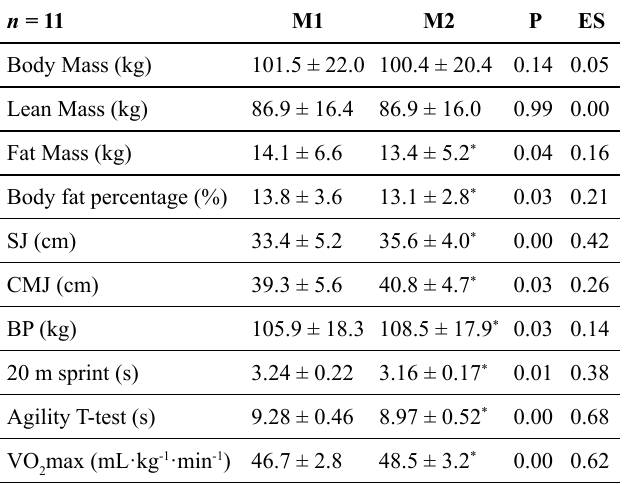
Table I – Anthropometric and physical performance characteristics of the professional basketball players at moment 1 and 2 evaluations. Data are presented as mean ± SD.